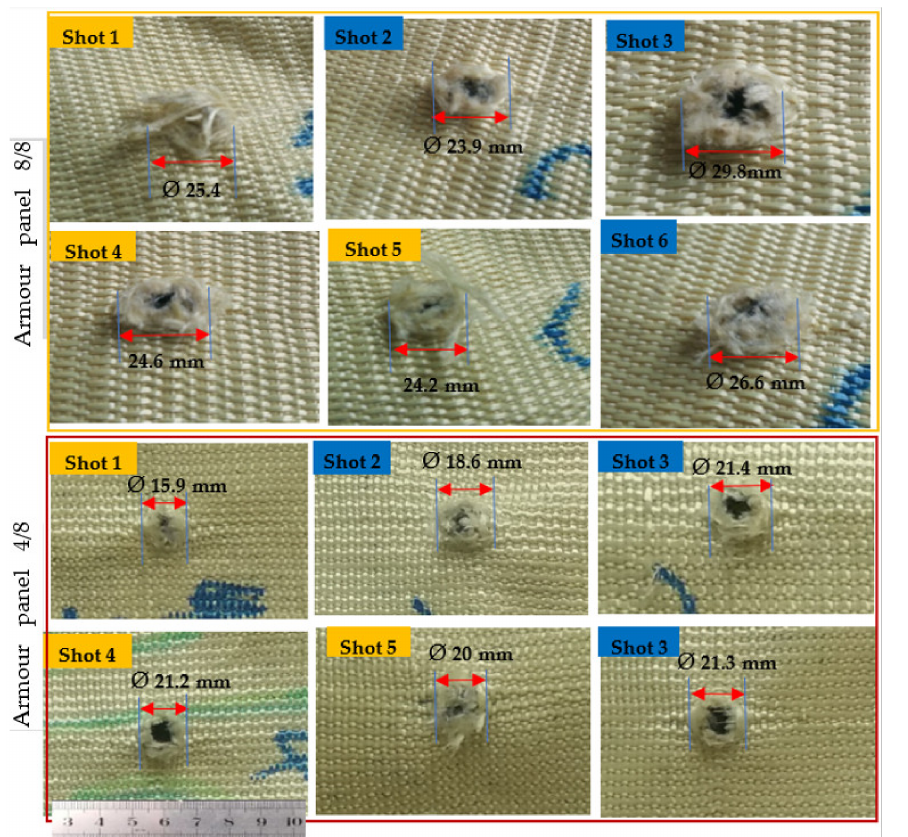
Figure 8. Typical impact surface damage and its maximum diameter of armour panels made of fabric variants 8/8 and 4/8 at moulded (shot 1, 4 and 5) and nonmoulded areas (shot 2, 3 and